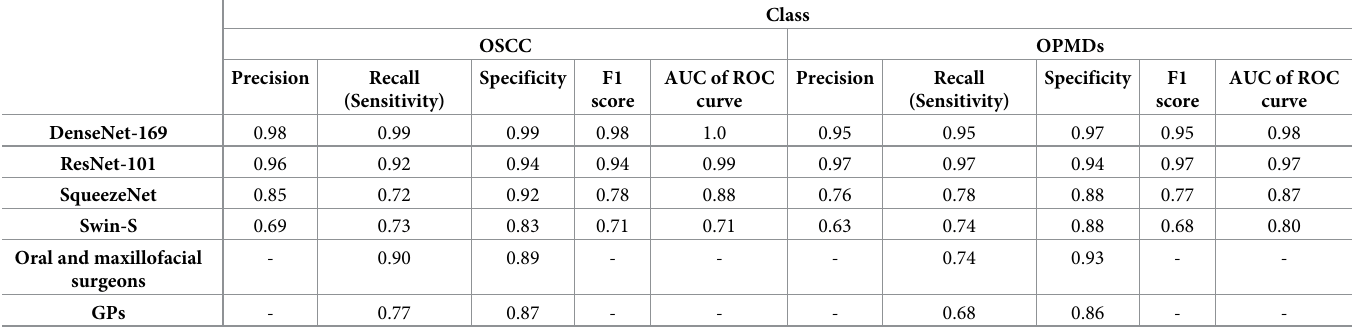
AUC, area under the curve; ROC, receiver operating characteristics; GPs, General